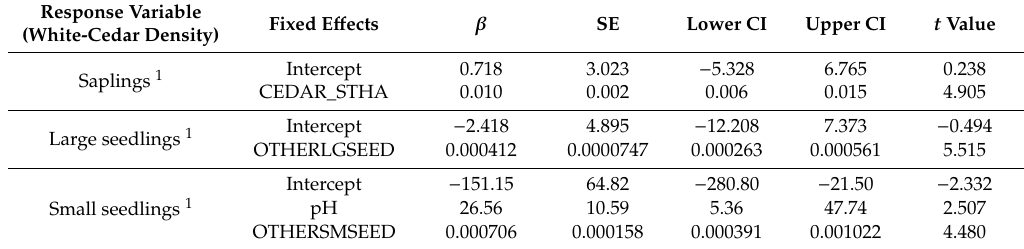
Table 4. Most parsimonious models predicting stem density of white-cedar regeneration by height class. Confidence intervals (CI) are two standard deviations. All models also included random e ff ects for site (saplings) or plot nested within site (small and large seedlings). β = model coe ffi cient, SE = standard